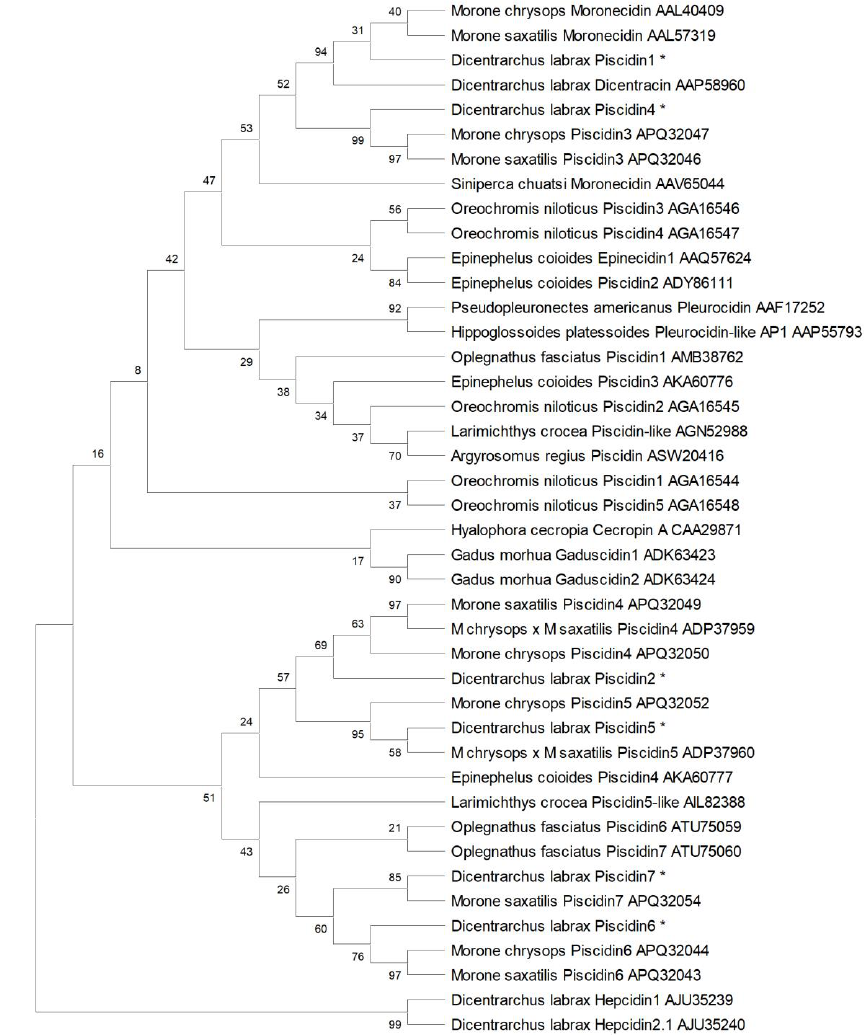
Figure 5. Phylogenetic analysis of piscidin peptides. The evolutionary history was inferred by using the Maximum Likelihood method and Jones–Taylor–Thornton (JTT) matrix-based model [35]. The bootstrap consensus tree inferred from 10,000 replicates is taken to represent the evolutionary history of the taxa analyzed [36]. Branches corresponding to partitions reproduced in less than 50% bootstrap replicates are collapsed. The percentage of replicate trees in which the associated taxa clustered together in the bootstrap test (10,000 replicates) are shown next to the branches [36]. Initial tree(s) for the heuristic search were obtained automatically by applying Neighbor-Join and BioNJ algorithms to a matrix of pairwise distances estimated using a JTT model. This analysis involved 42 amino acid sequences. All positions with less than 95% site coverage were eliminated. There were a total of 56 positions in the final dataset. Evolutionary analyses were conducted in MEGA X